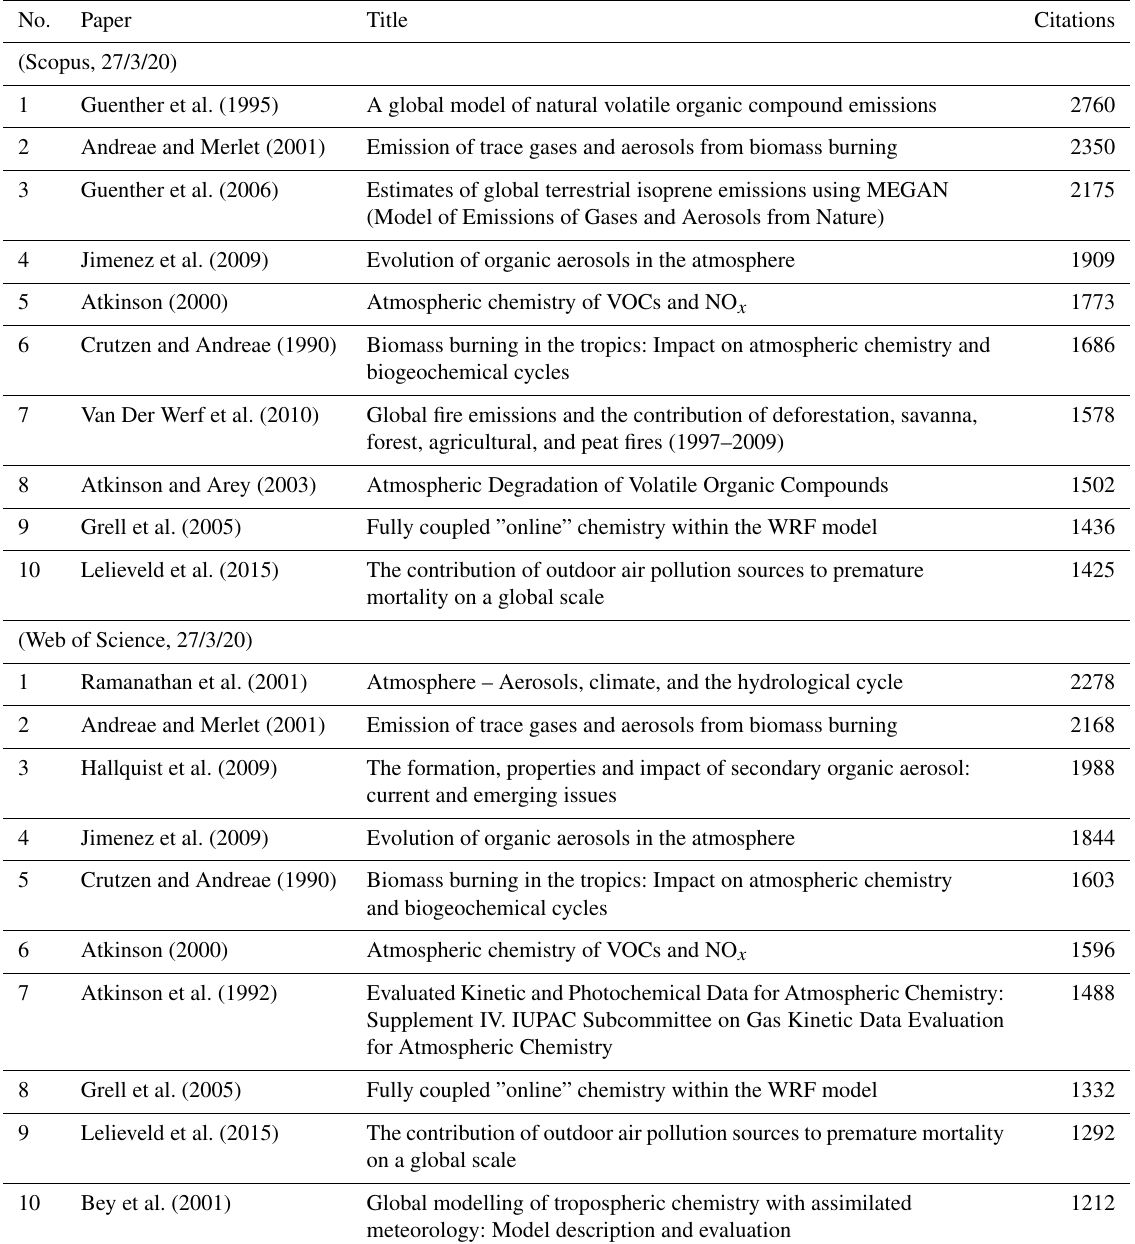
Table 1. Top 10 cited atmospheric chemistry papers (atmospheric +